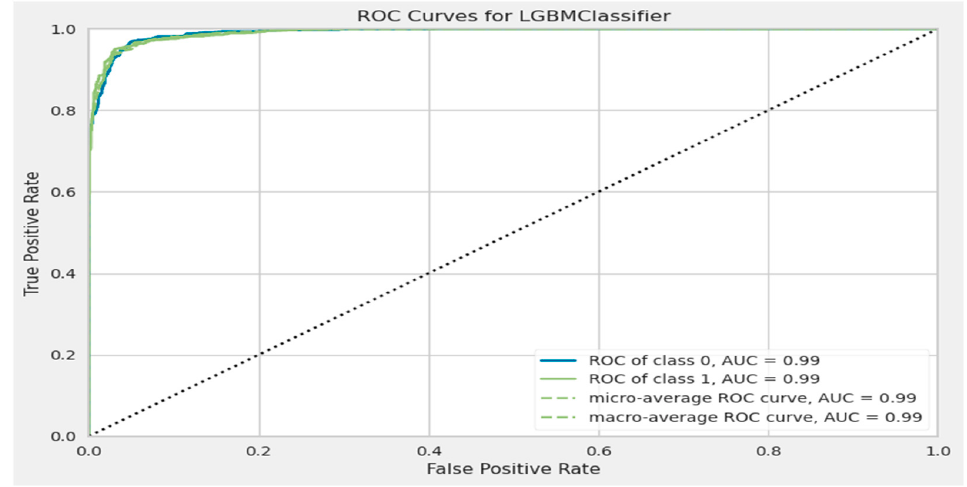
Figure 12. The lightGBM model’s ROC curve after the hyper-parameter tuning.